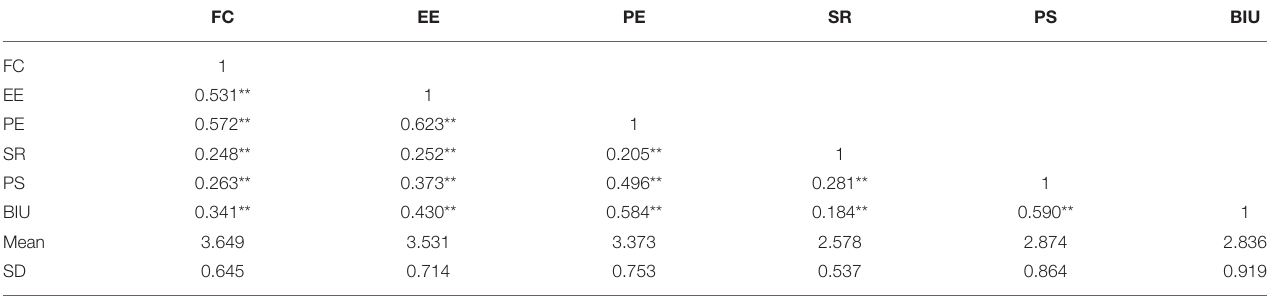
TABLE 3 | Correlations, means, and standard deviations for measured variables. FC EE PE SR PS BIU